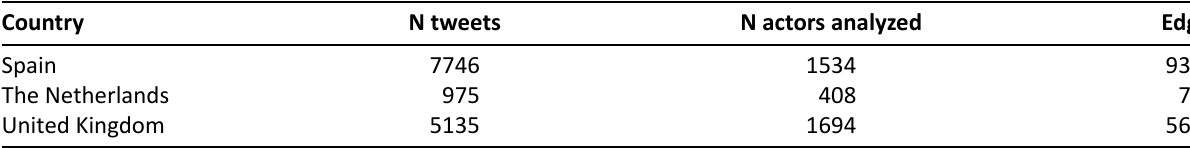
Table 1. Total number of tweets analyzed, per country.